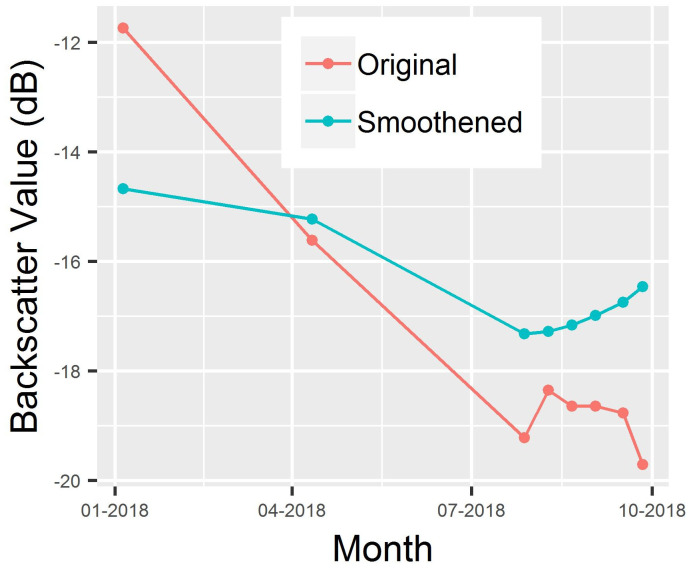
Time series backscatter signal at flooded location.